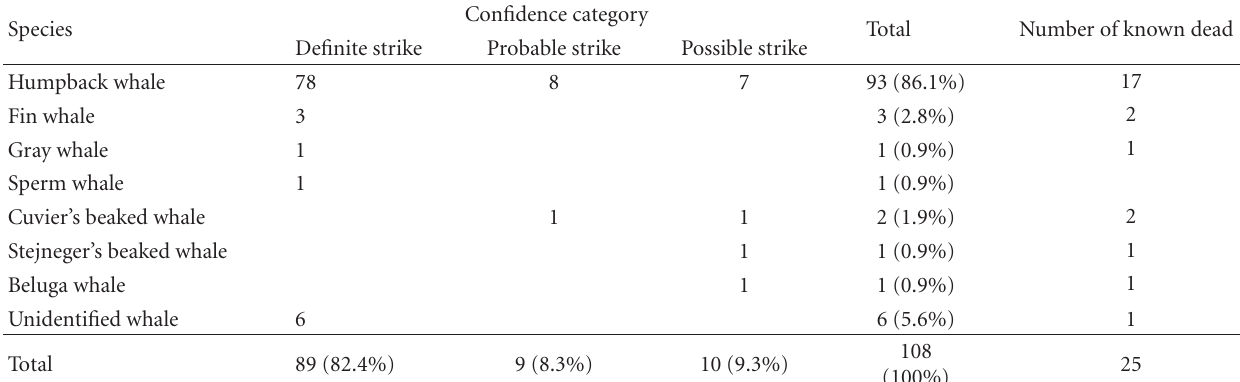
Table 2: Summary of whale-vessel collisions reported in Alaska 1978–2011. Rejected reports are not included.